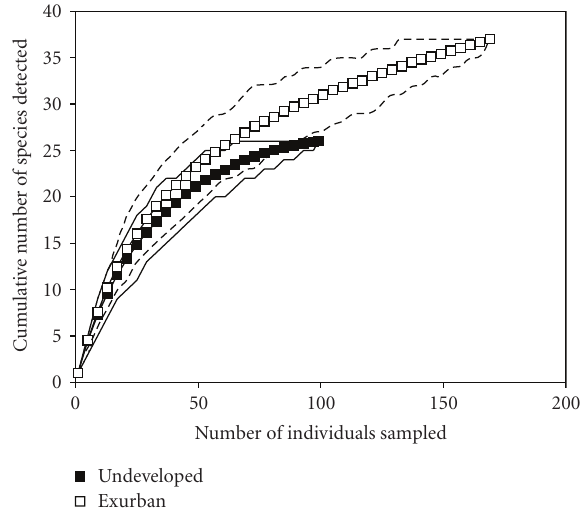
Figure 2: Bird species richness in each habitat class measured with rarefaction curves at the scale of habitat class. Rarefaction curves describe how the number of species changes with the number of individuals sampled, thus controlling for both sampling e ff ort and bird density. Thick lines indicate species richness (open points: exurban areas; filled points: undeveloped areas) and thin lines indicate 95% confidence intervals (dashed thin line: exurban areas; solid thin line: undeveloped